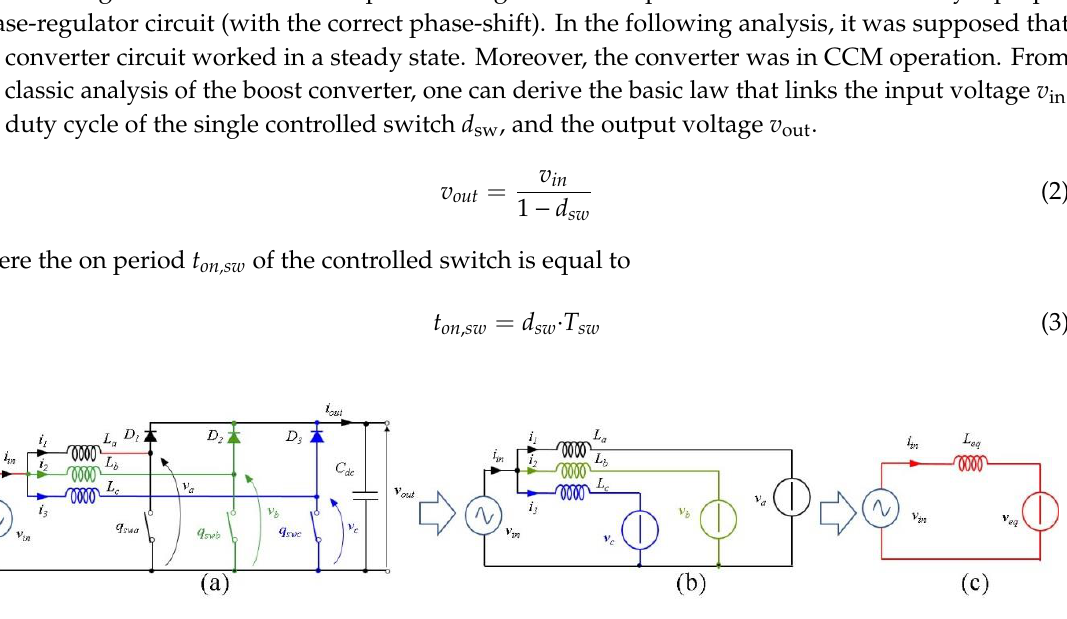
Figure 2. ( a ) Three-stage interleaved boost PFC circuit schematic, ( b ) equivalent averaged-circuit model circuit, ( c ) Thevenin equivalent circuit.